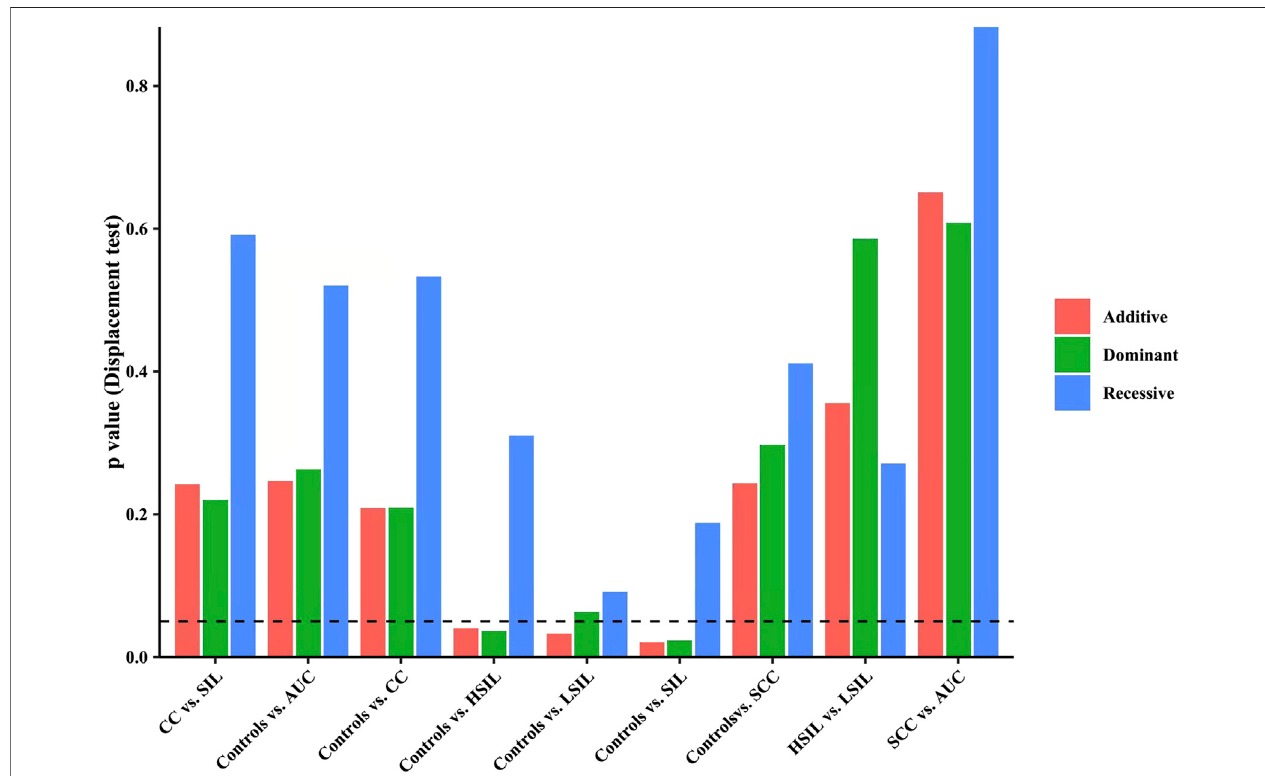
FIGURE 3 | Results after 10,000 permutation tests show the comparison of genotypes and allele distribution frequencies between groups.